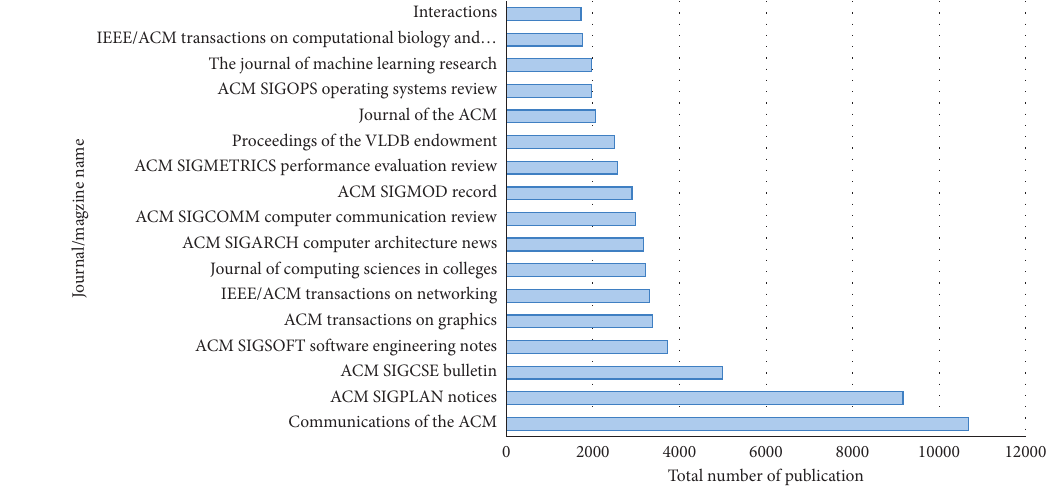
Figure 3: Magazine/Journal names and number of articles.